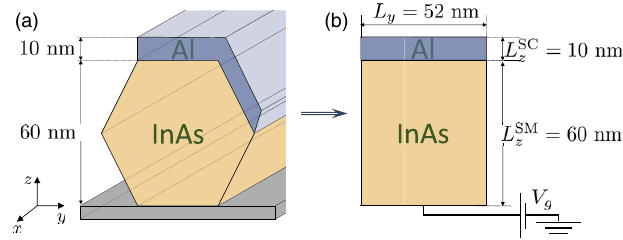
FIG. 1. (a) SM-SC heterostructure based on hexagonal nano- wire. 10-nm-thick Al layer (blue) is deposited on two facets of InAs (brown) hexagonal wire with a height of 60 nm. The back gate is shown schematically in gray. (b) Rectangular geometry of the wire that supports the same number of subbands. The back gate is emulated by a boundary condition at the bottom.